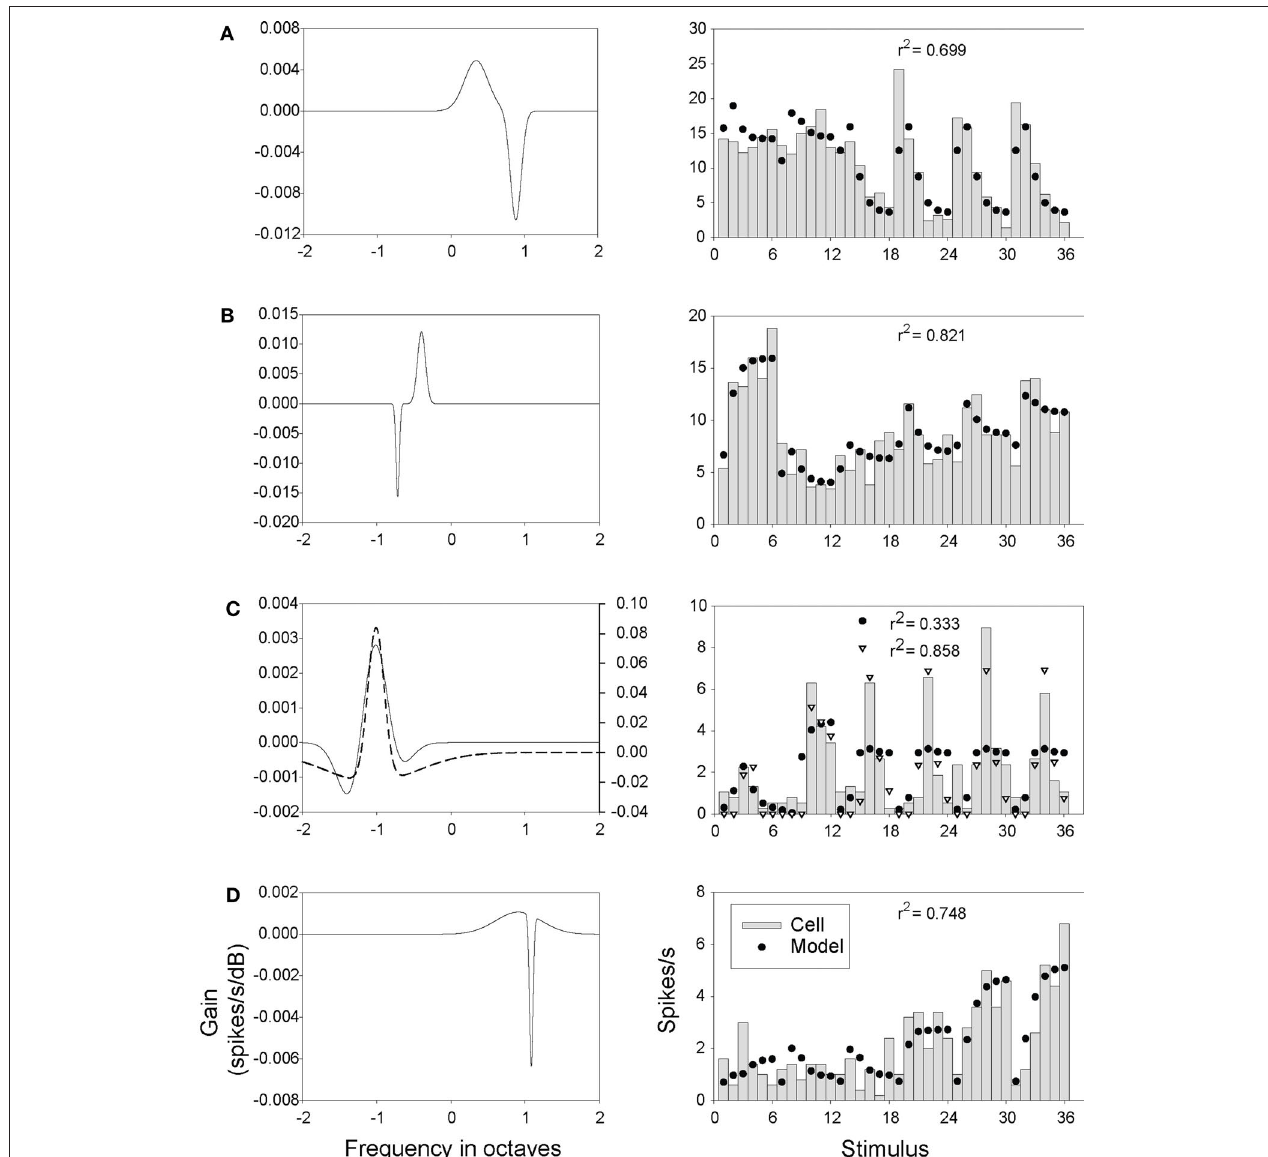
FiGure 11 | doG model filters and outputs. Details as in Figure 10 , except that the optimization procedure was applied to Eq. 1 using the DoG weight function to obtain the filters ( A-d , solid lines ). The filter represented by the dashed line (C) was obtained by applying the optimization procedure to Eq. 2 (which added rectification to Eq. 1). The output of this model ( open triangles ) is shown on the left